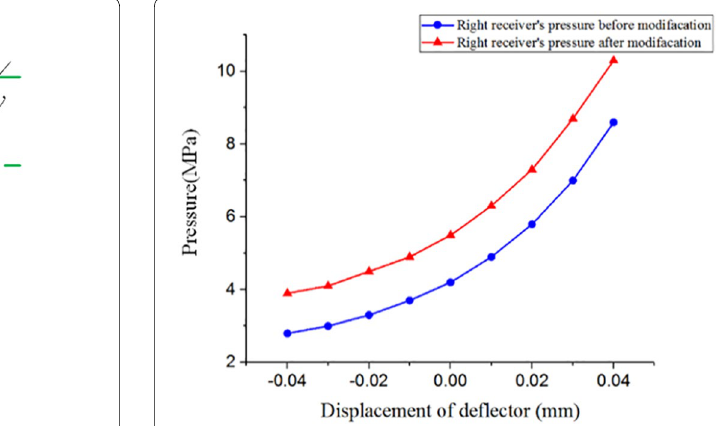
Figure 23 Effect of modification on the receiver pressure calculation